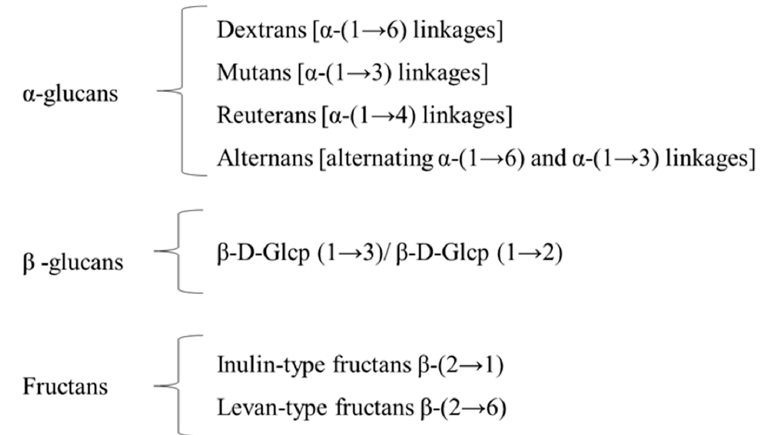
Figure 1. Classification of HoPS. The majority of HoPS-producing LAB produce a single crase enzyme, but some contain more than one glycansucrase gene and therefore may synthesize more than one type of